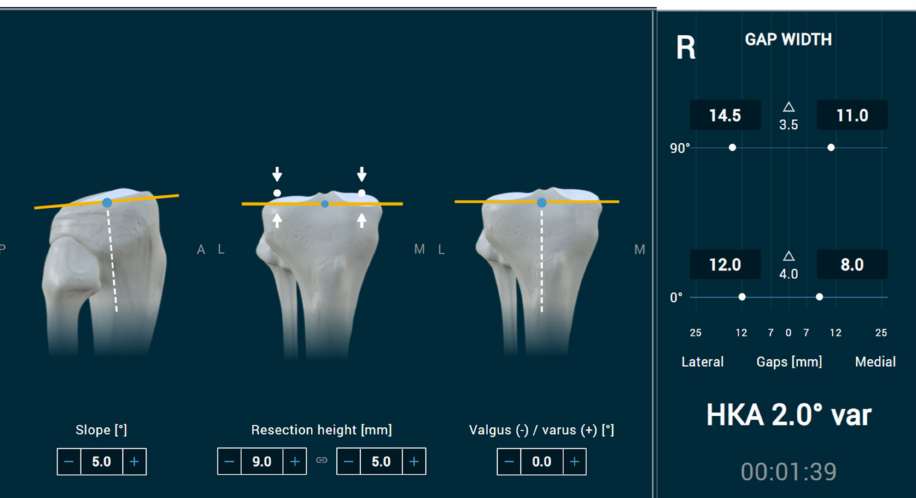
Figure 1. Tibia decisions of slope, resection height, and varus/valgus cut, with all referenced to the centre point (blue dot) of the tibia and both directly linked to the extension/flexion gap size. For the femur, seven categories of decision—one for distal varus/valgus cut angle, one for the amount of distal bone cut (medial and lateral femoral condyles), one for femoral rotation (relative to the posterior condyles), one for posterior condyle resections—were integrated. The reference is again the mechanical axis of the femur. These posterior condyle resections can be modified by three methods. Changing the femoral component size, altering the AP positioning of the femoral component, or changing the femoral